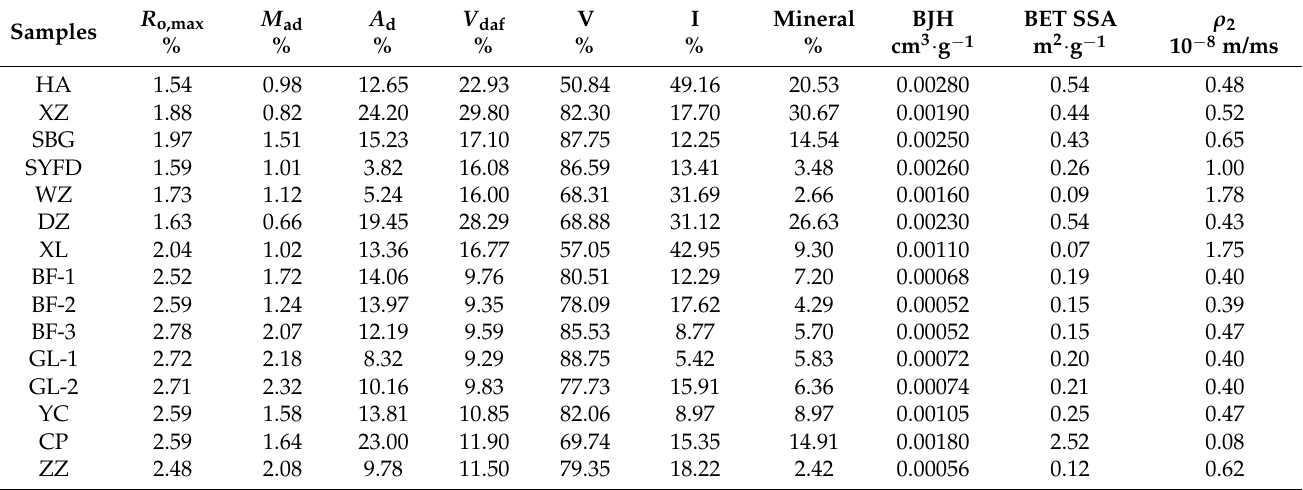
Table 1. Results of proximate analysis and maceral